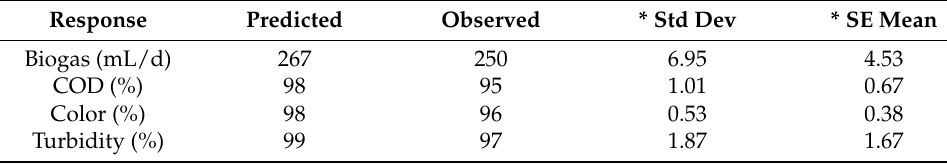
Figure 9. Selected numerical optimized condition ramp plots. Table 5. Modified RSM-BBD optimum conditions experimental validation.